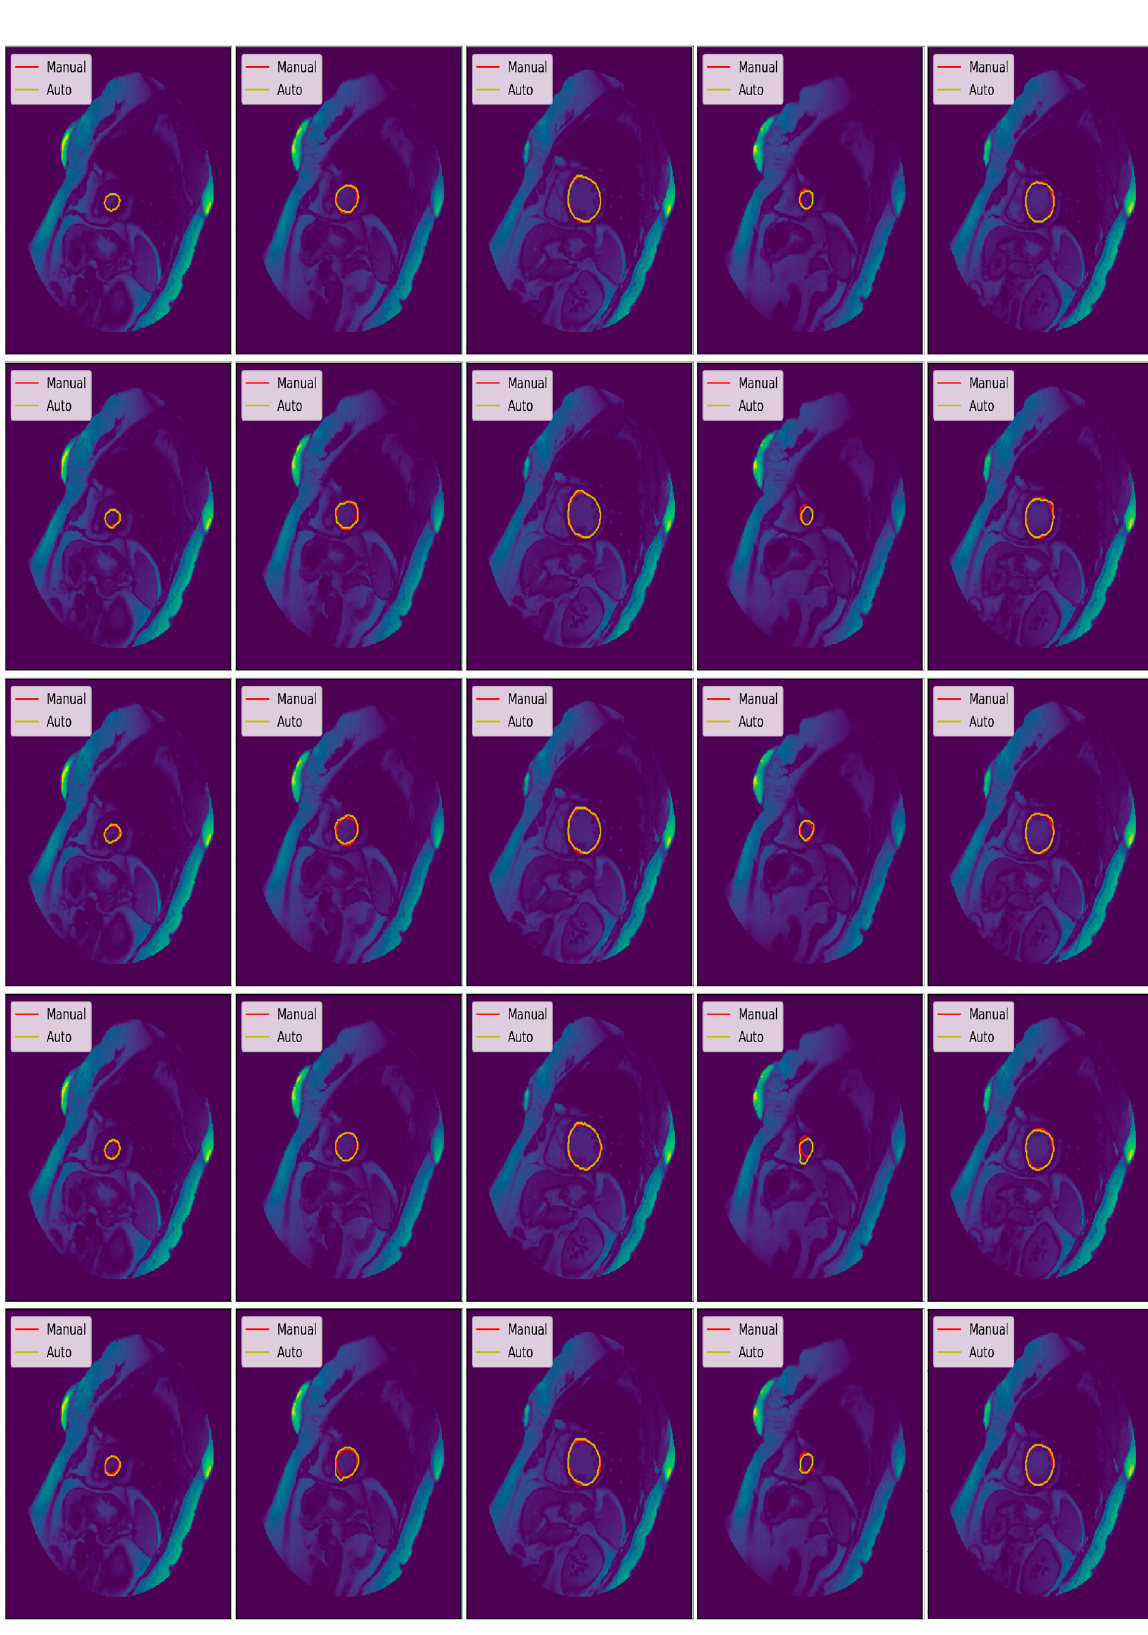
Figure 12. Automatic and manual segmentation results of the endocardium from the training set of a normal subject (SC-N).